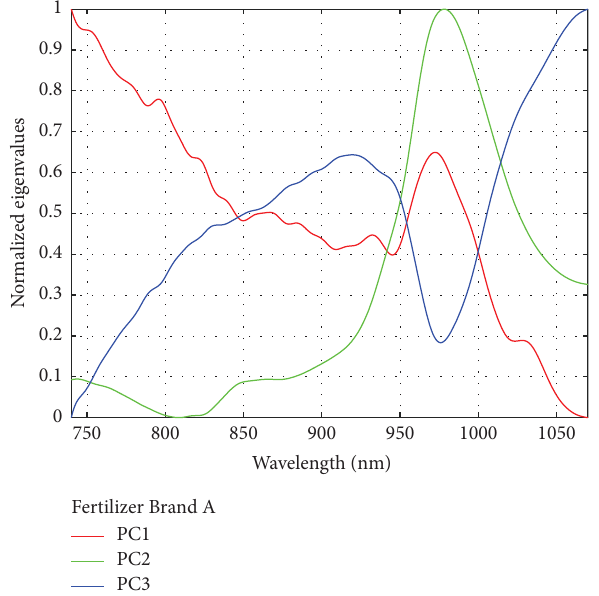
Figure 5: Eigenvectors for the identifcation of fertilizer brand A category.